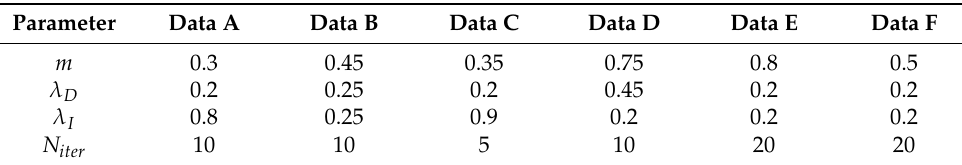
Table 3. Parameter setting of three methods.